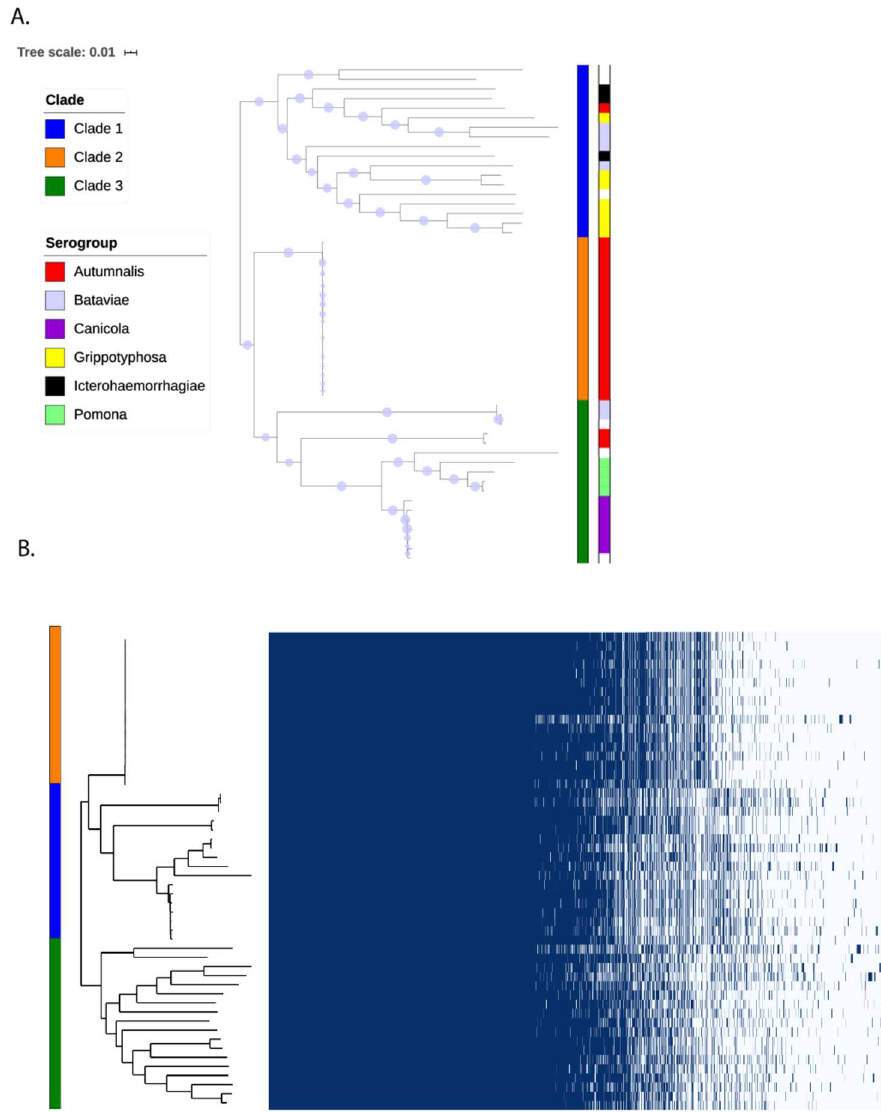
Fig 5. The Leptospira ST34-like strains have limited genetic variation. A: ML phylogeny based on whole genome sequences of L . interrogans . Bootstrap values are shown with the size of circles in the middle of the branches, bootstraps lower than 70 are not shown. Clade and serogroup names are given by the color codes (from inner to outer strips). White color indicates that the information was not available. B: Matrix showing absence or presence of 5,543 genes found in the pangenome of L . interrogans strains. Clade names are given by the color codes.